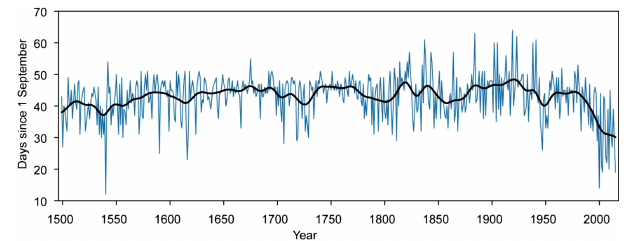
Figure 4. Pearson correlation coefficients between grape-harvest dates and Czech temperatures in the 1811–2010 period for months and seasons; broken horizontal line indicates significant correlations for one-tail test ( p = 0.05, N = 200).